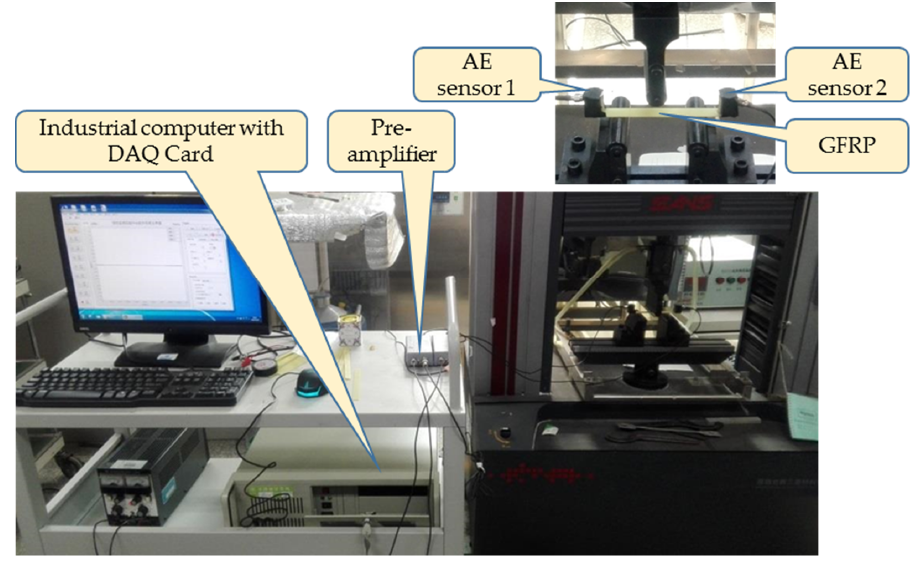
Figure 15. The three-point bending load experimental system.